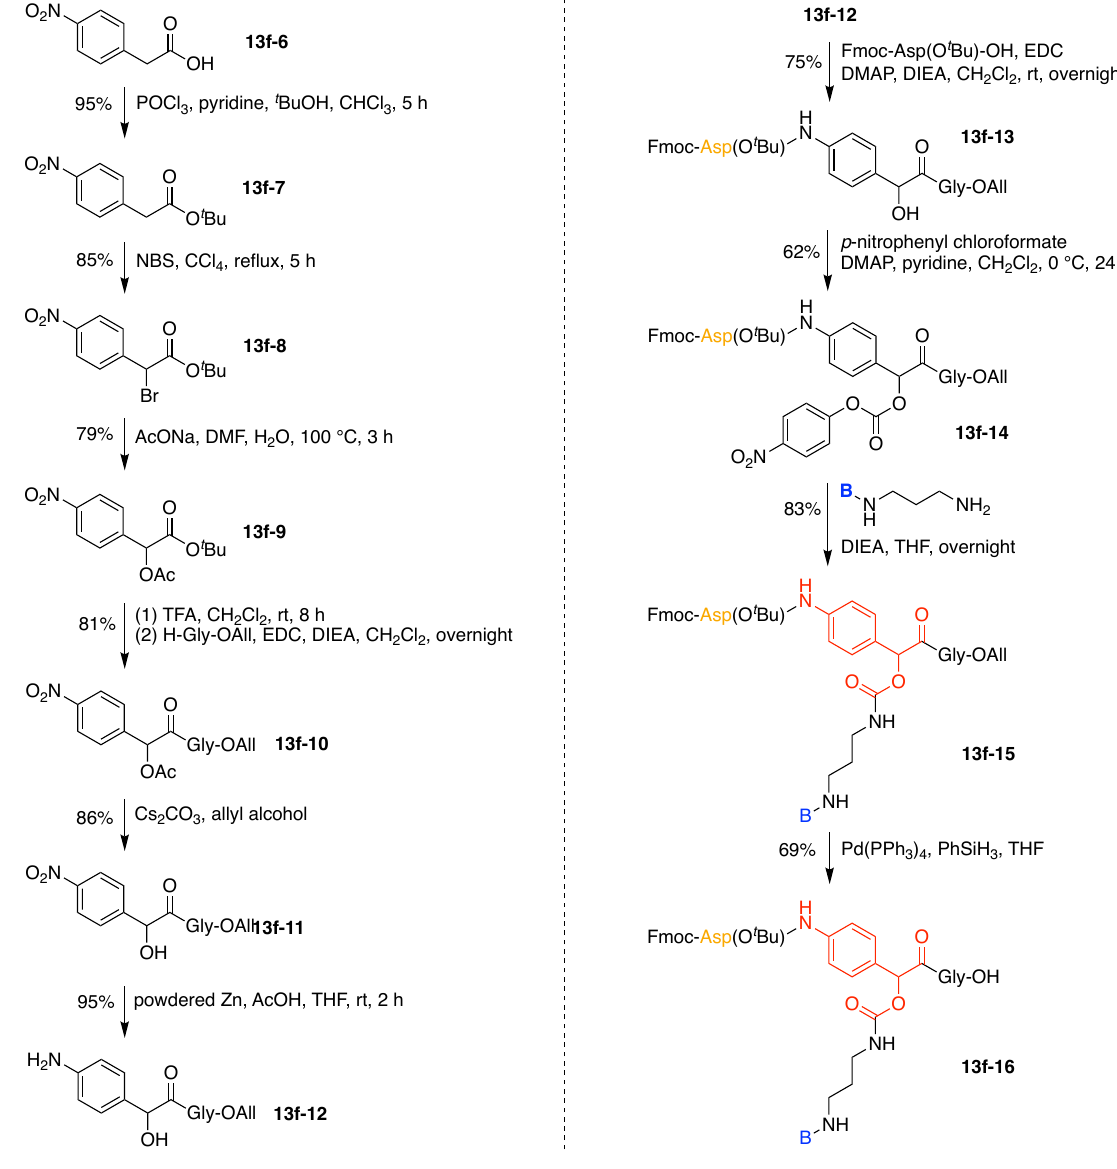
Figure 67. Synthesis of a p -aminomandelic acid building block.